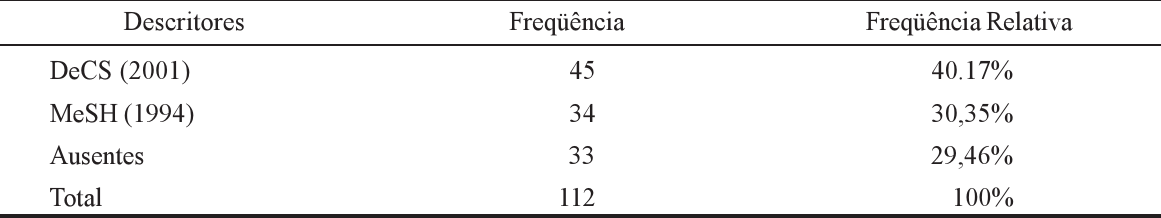
TABELA 3 - Freq(cid:252)Œncia absoluta e relativa dos descritores em l(cid:237)ngua inglesa citados mais de uma vez em artigos de revistas nacionais de angiologia e cirurgia vascular no per(cid:237)odo de 1995 a 2000.